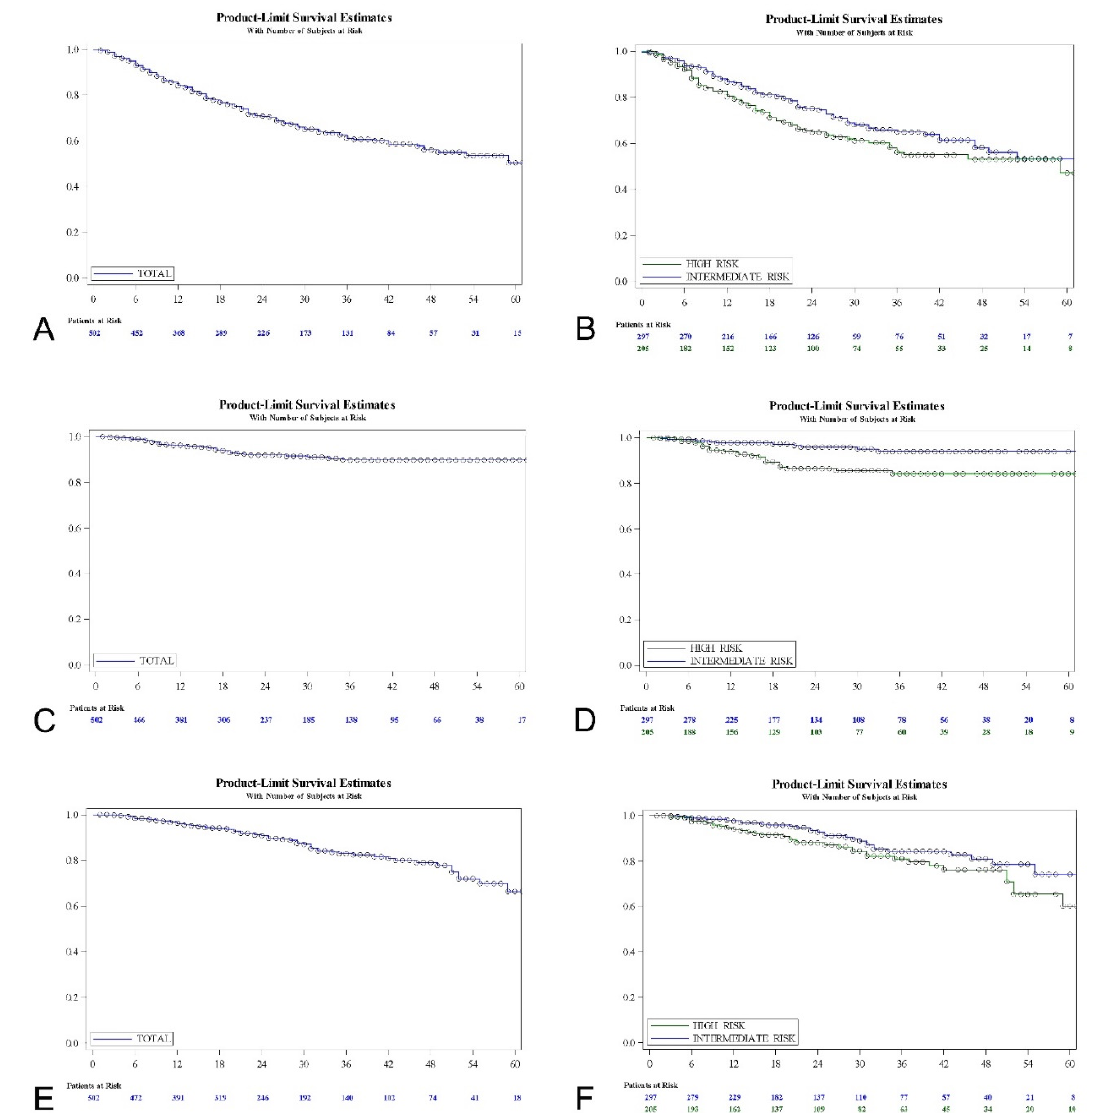
Figure 2. Recurrence-free survival, FAS population ( A ) and EAU risk groups ( B ); progression-free survival, FAS population ( C ) and EAU risk groups ( D ); overall survival, FAS population ( E ) and EAU risk groups ( F